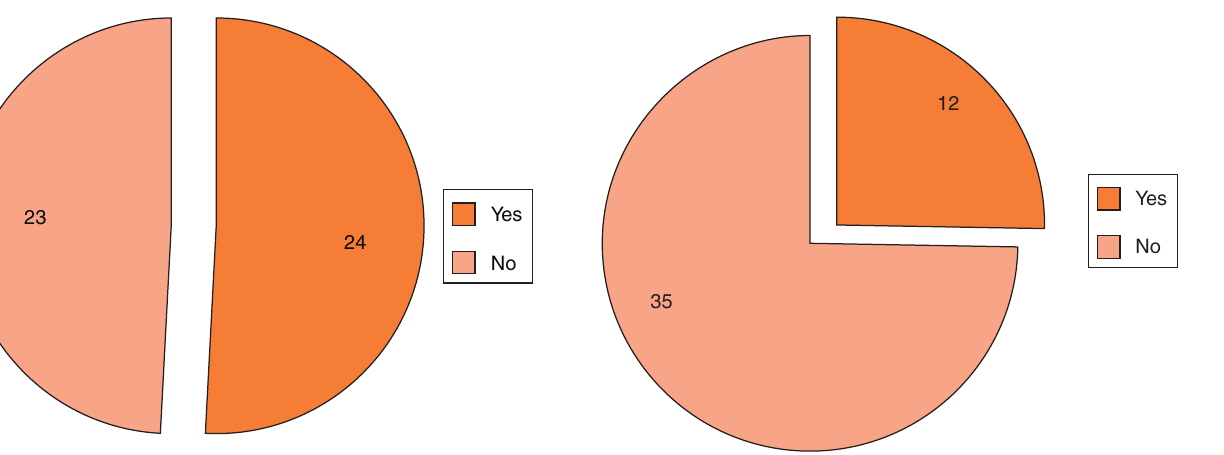
Figure 6 Knowledge about the different types of hearing loss ( n =